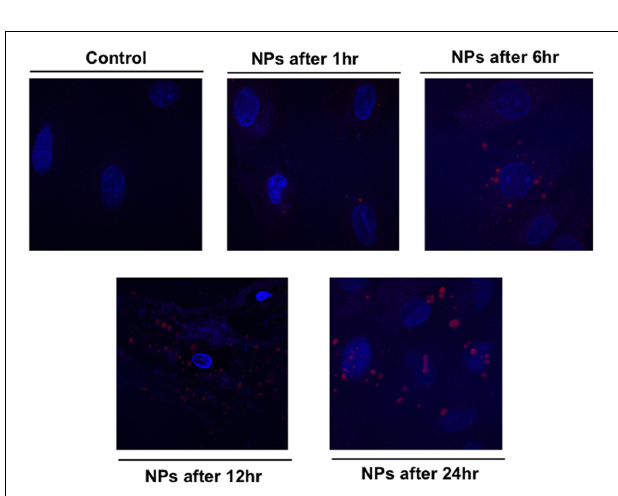
FIGURE 4 | Confocal fluorescence image showing cardiac myocytes exposed to 200 ng/mL RhB-loaded PLGA NPs over different time period. The blue color presents the nucleus stained with DAPI.